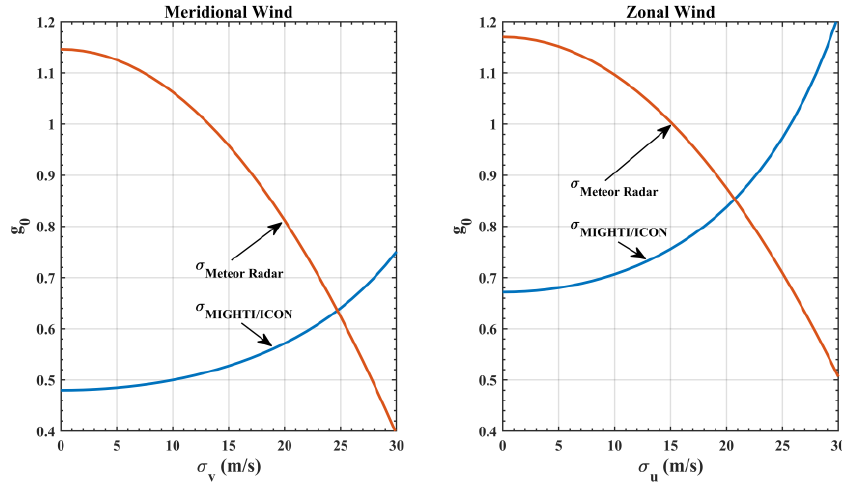
Figure 2. Relations between g 0 and the errors σ for meridional wind and zonal wind at 94–98 km. The left column shows the meridional winds and the right column shows the zonal winds.